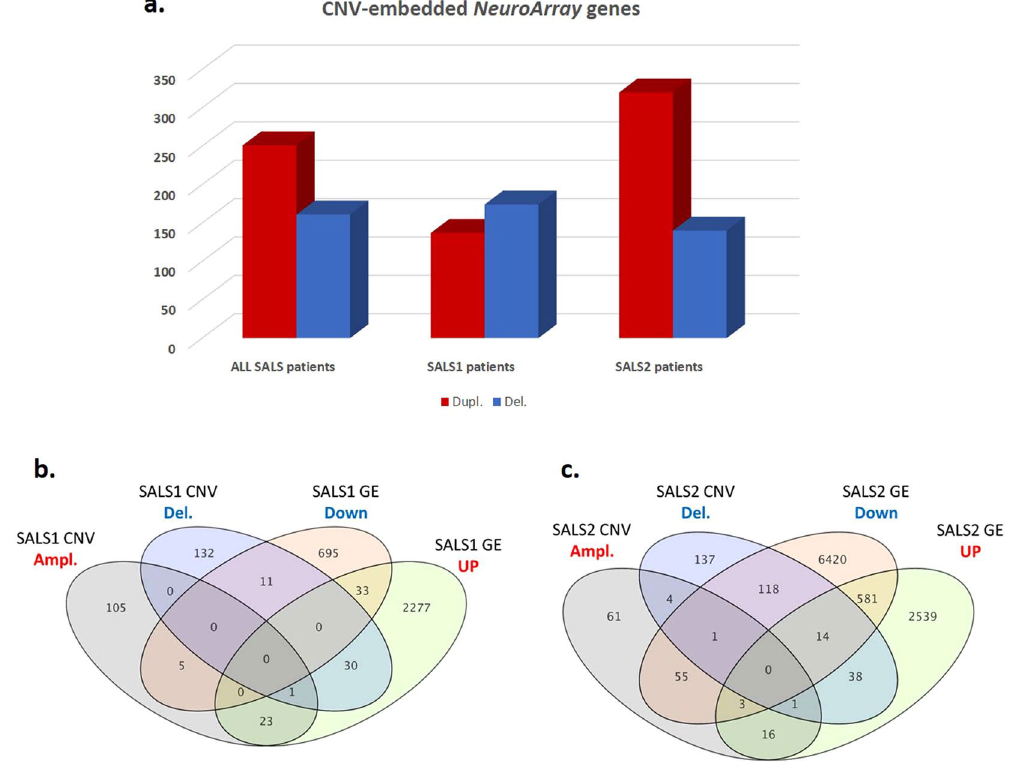
Figure 2. Integrative analysis of DNA copy number and expression variation in SALS patients reveals a good number of overlapping ALS candidate genes. ( a ) Graphical overview of the most frequent ( ≥ 10%) CNV- embedded genes detected in SALS patients, both with and without the assignment into the hierarchically determined two sets (SALS1 and SALS2). ( b , c ) Venn diagrams compare the number of protein-coding genes obtained from CNV analyses with the genes found to be differentially expressed in SALS1 ( b ) and SALS2 ( c )